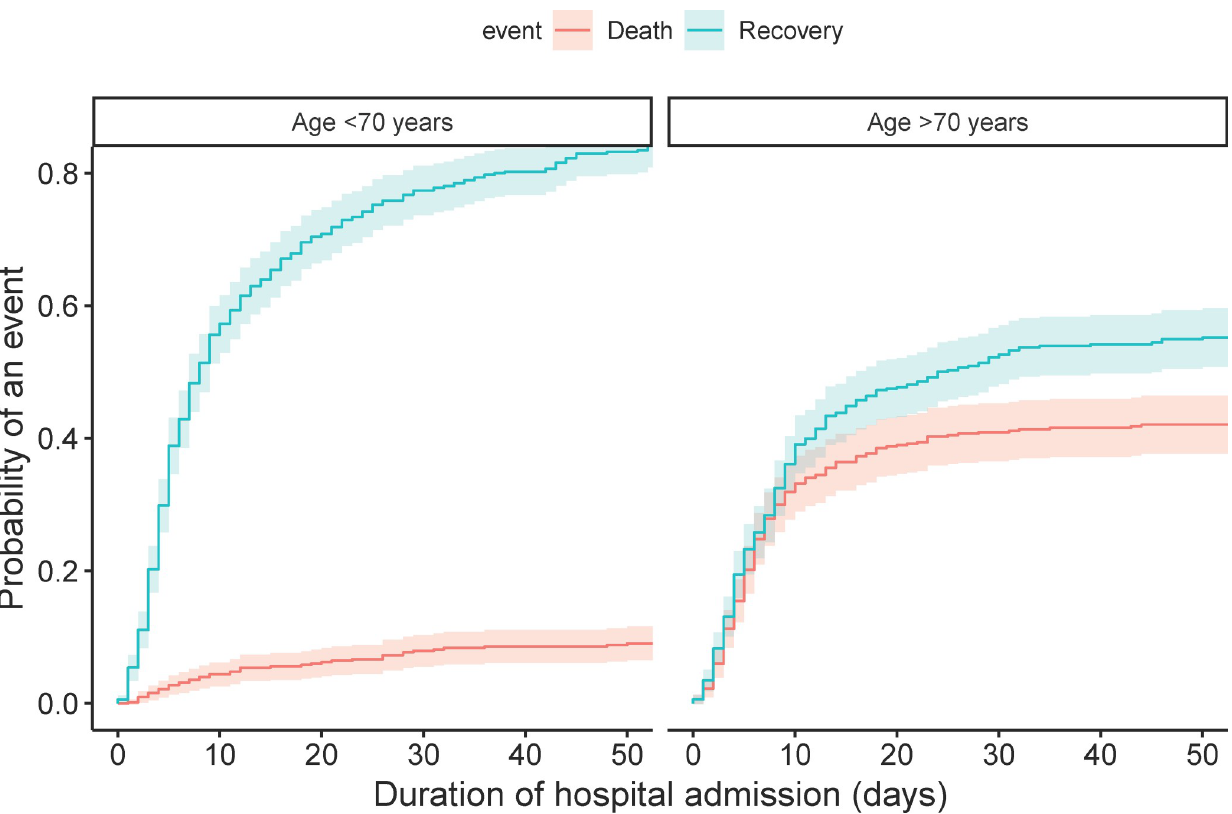
Fig 2. Cumulative incidence plot of death and recovery in the total population, separated by age group. Gray’s test indicated a significant difference between two groups for both death (p < 0.001) and recovery (p < 0.001). The probability of death for patients aged < 70 years after one, two and three weeks of hospital admission was 3.6% (95% CI 2–5.2), 5.4% (95% CI 3.4–7.4), and 6.5% (95% CI 4.3–8.6), respectively, whereas for patients aged � 70 years, the probability of death was 27.8% (95% CI 23.8–31.8), 36.4% (95% CI 32.1–40.7), and 39.2% (95% CI 34.8–43.5),